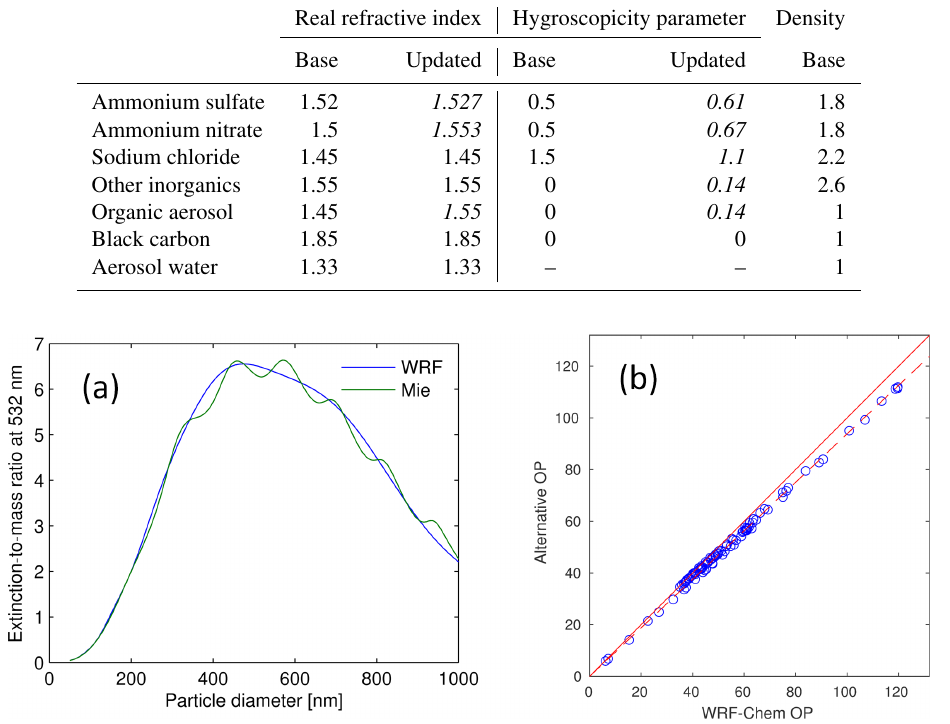
Figure 2. (a) Extinction-to-mass ratio for dry conditions (20% RH) as a function of dry particle diameter considering a monodisperse aerosol distribution of fixed aerosol composition equal to the mean of the data analyzed. Blue and green lines represent results using optical properties code from WRF-Chem and the alternative approach, respectively. (b) Scatterplot comparing aerosol water (µgm − 3 ) estimated by WRF-Chem routines for the forecast simulations (MOSAIC four-bin) and using the alternative approach at 80% RH during 02:00– 05:00UTC of the flight analyzed in this study. The solid red line indicates the 1 : 1, line and the dashed red line represents the regression line (slope of